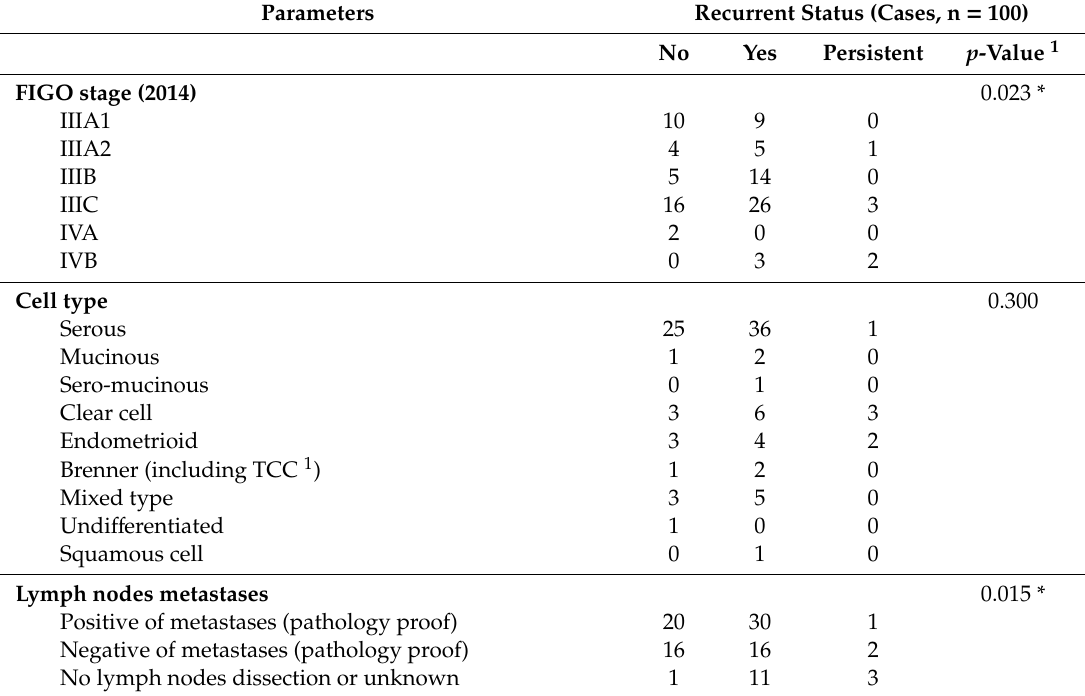
Table 8. Parameters a ff ecting recurrence / persistence in optimally debulked